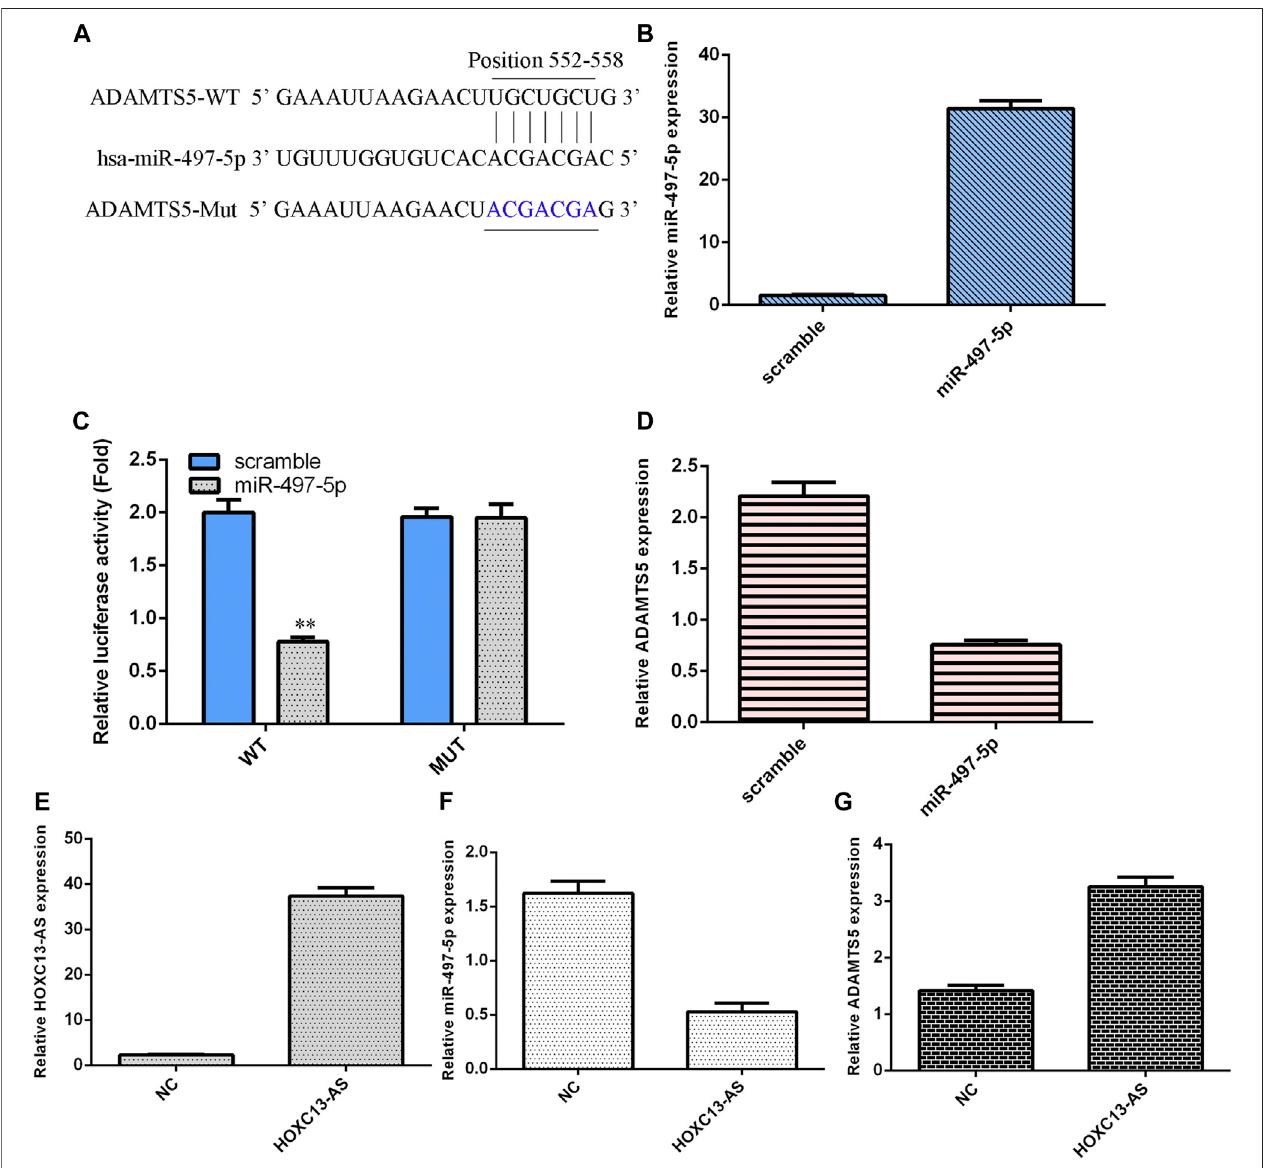
FIGURE 4 | miR-497-5p targets ADAMTS5 expression in NP cells. (A) miR-497-5p was predicted to link with the ADAMTS5 3 ′ -UTR using TargetScan software. (B) miR-497-5pwasobviouslyupregulatedinNPcellsaftertreatmentwiththemiR-497-5pmimic. (C) LuciferaseanalysisdatashowedthatmiR-497-5poverexpression inhibited the luciferase expression of the wild-type reporter gene but not the mutated 3 ′ UTR vector. (D) Ectopic miR-497-5p expression decreased ADAMTS5 levels in NP cells. (E) HOXC13-AS expression was measured by qRT-PCR. (F) Upregulation of HOXC13-AS expression inhibited miR-497-5p expression in NP cells. (G) ADAMTS5 expression was measured by qRT-PCR. ** p <